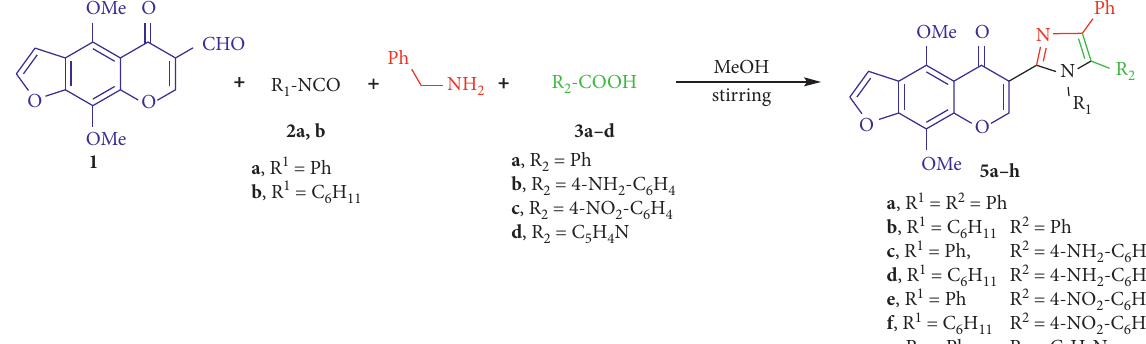
Scheme 3: Synthesis of compounds 5a–h .